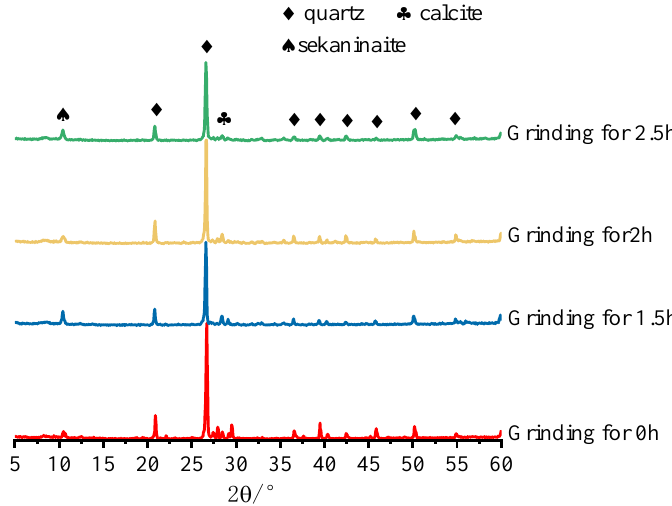
Figure 8. XRD patterns of IOTs at different grinding times.